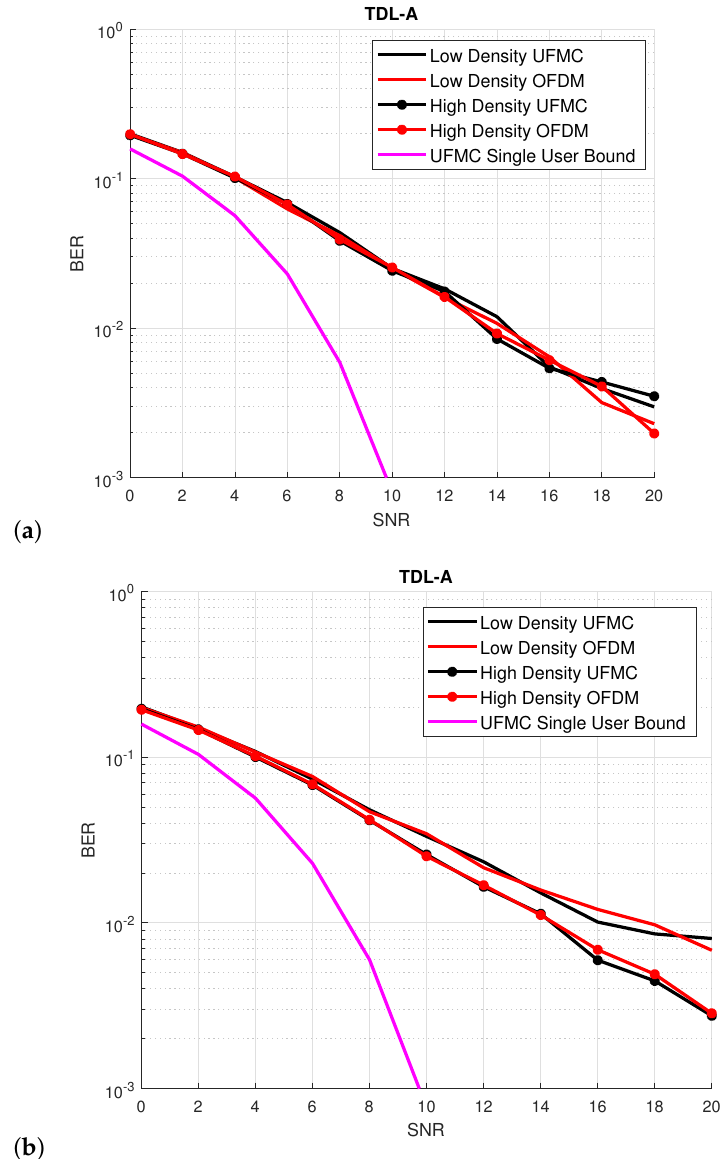
Figure 8. Uncoded bit error rate (BER) of UFMC vs OFDM under tapped delay line A (TDL-A) channel and maximal Doppler Shift: ( a ) maximal Doppler shift f d = 10 Hz; ( b ) maximal Doppler Shift f d = 100